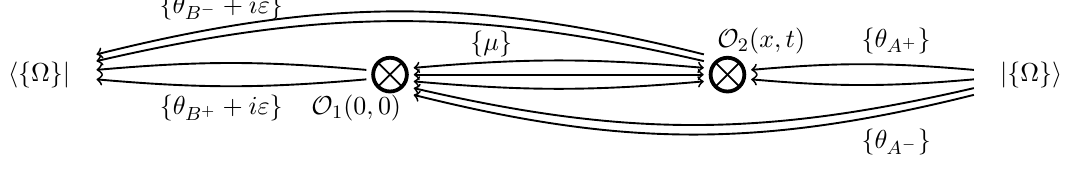
Figure 2 . Graphical interpretation of the LM series (5.6). The set f (cid:18) g represents the particles from the representative state j (cid:10) i that interact with the two-point function, whereas f (cid:22) g are intermediate particles between the two operators. Each physical amplitude is associated with additional phase factors, that depend on the partitions (ordering of the particles) and the contour for the (cid:22) -integrals. Representation (5.6) is perhaps the most transparent from a physical point of